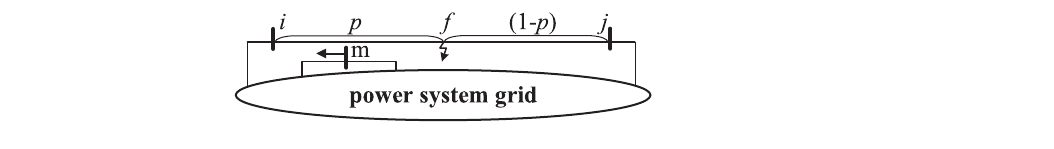
FIGURE 1 | Model of power system short-circuit calculation.